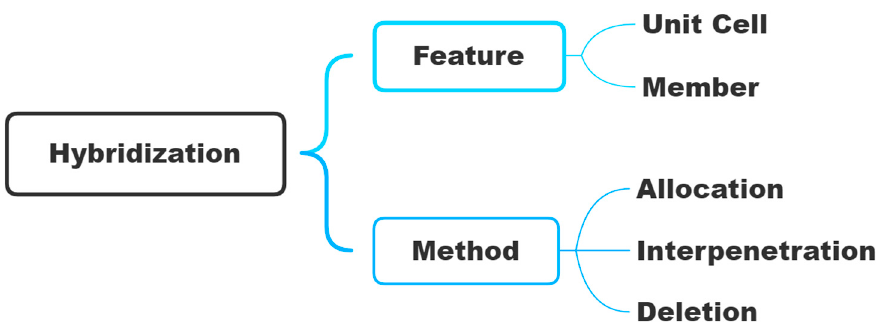
Figure 13. Classification proposed for the hybridization of cellular materials, divided into two decision levels: the feature to which it is applied and the method used to define it.